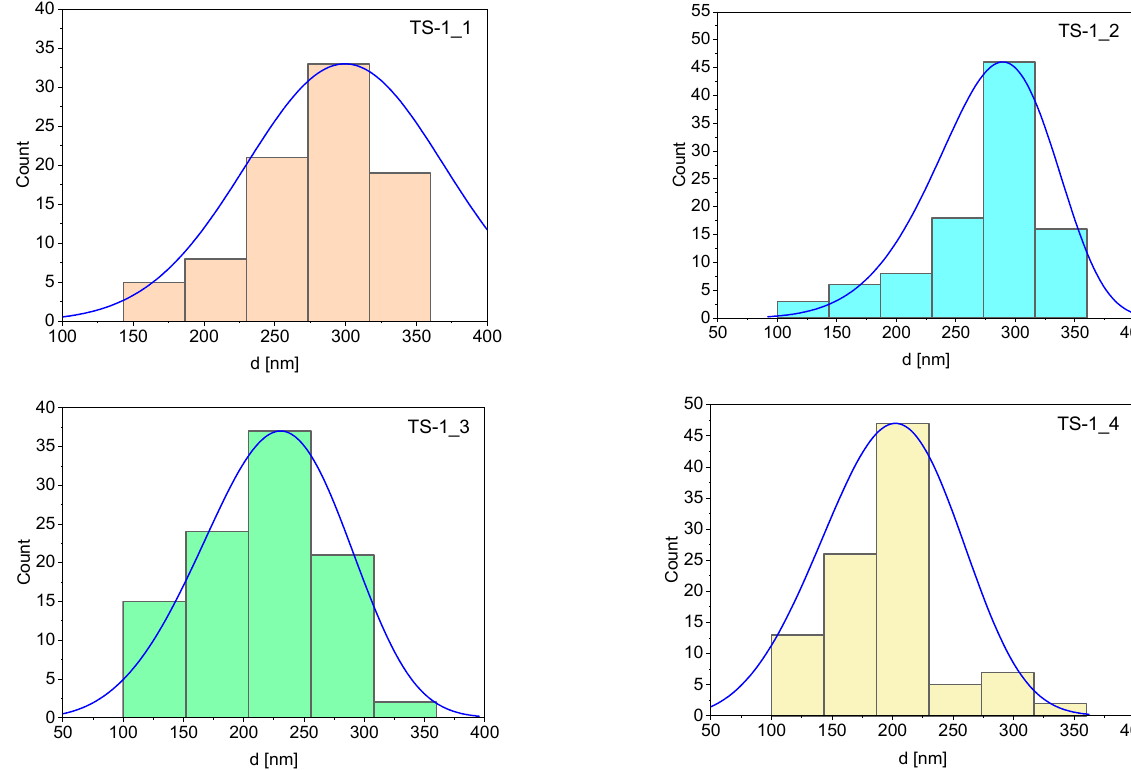
Figure 5. The particle-size distribution of TS-1 materials. Table 2. The statistical data concerning the particle size distribution.